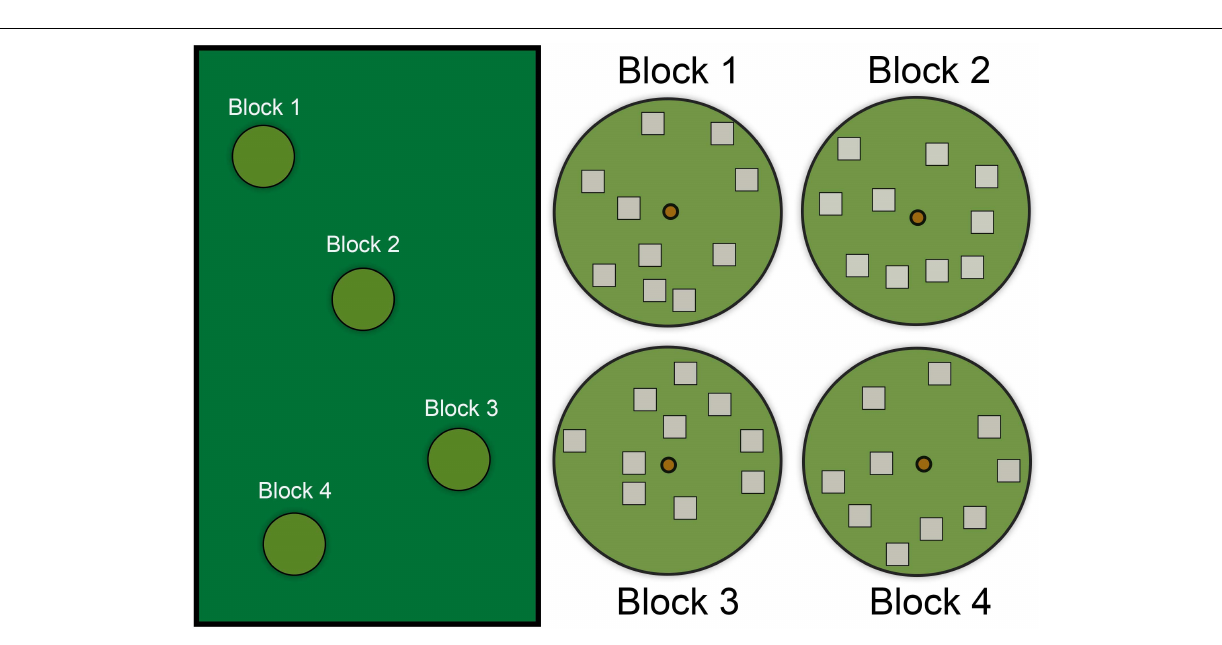
Frontiers in Ecology and Evolution |